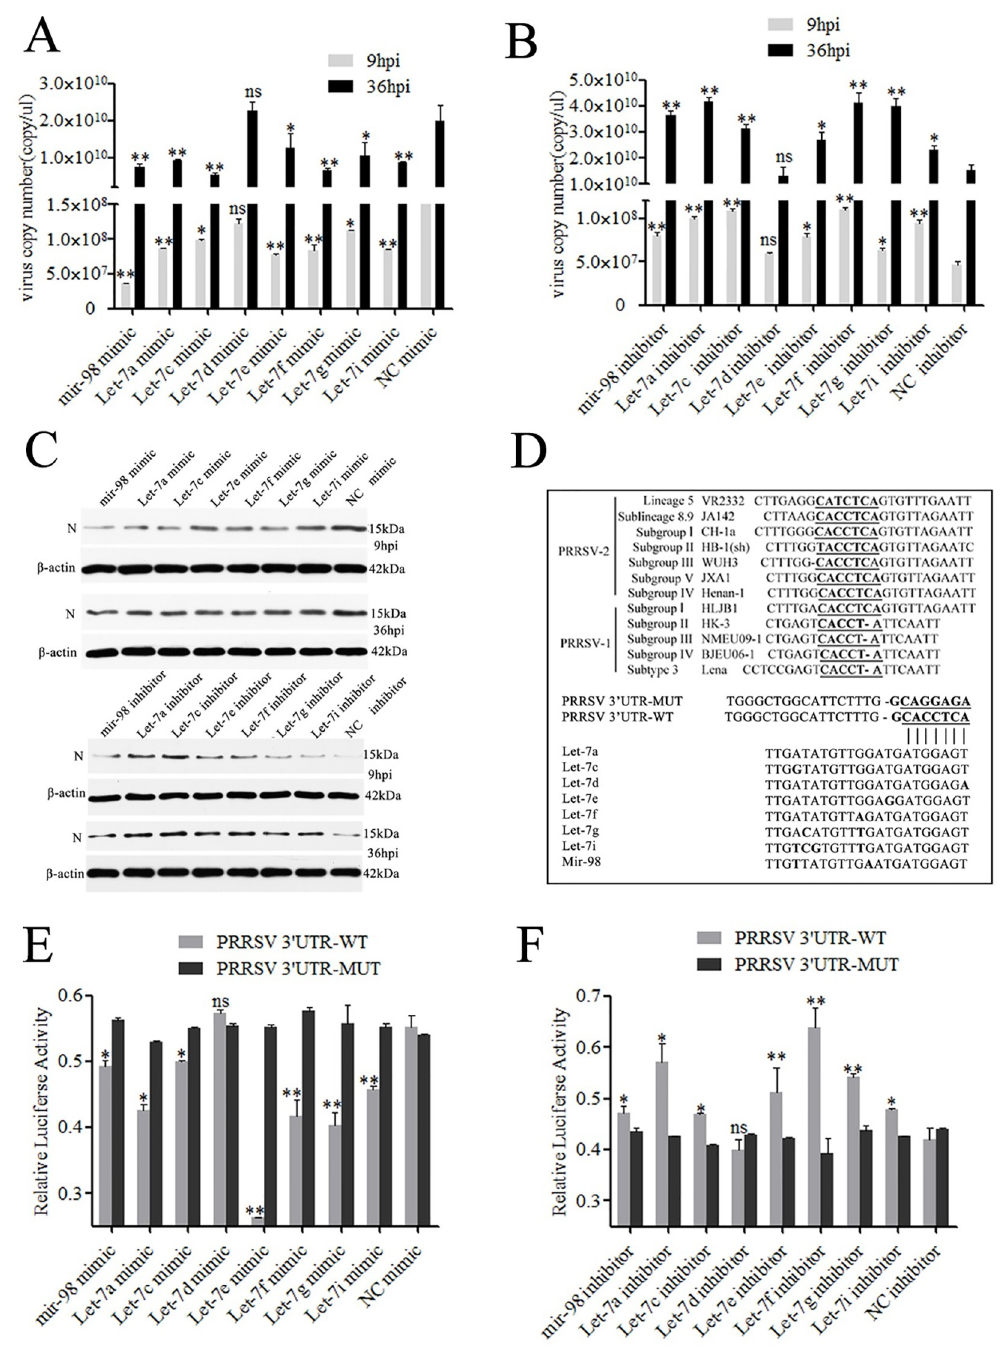
Fig 2. Let-7 family inhibits PRRSV-2 replication and directly target PRRSV-2 genomic RNA. Marc-145 cells were transfected with let-7 mimics/inhibitor, and then infected with PRRSV-2. The cells were collected at 9 hpi (9h) and 36 hpi (36h). The virus copy number was quantified by absolute quantitative PCR (A, B) and PRRSV-2 N protein was analyzed by Western blot (C). The let-7 binding site sequence in 3’UTR of 12 representative PRRSV-2 strains were predicted, compared and mutated (D). Luciferase activity was analyzed in Marc-145 cells co-transfected with PRRSV 3 0 UTR or PRRSV 3 0 UTR-MUT reporter constructs as indicated and either let-7 mimics (E) or let-7 inhibitor (F). Data are from three independent experiments (mean ± SD). � p < 0 . 05 and �� p < 0 . 01 (Student’s t test).